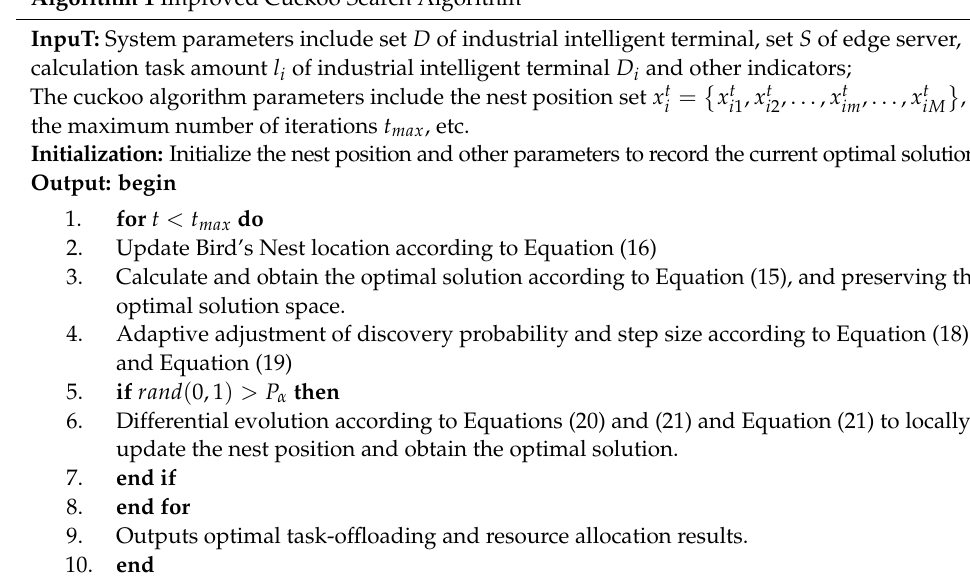
Algorithm 1 Improved Cuckoo Search